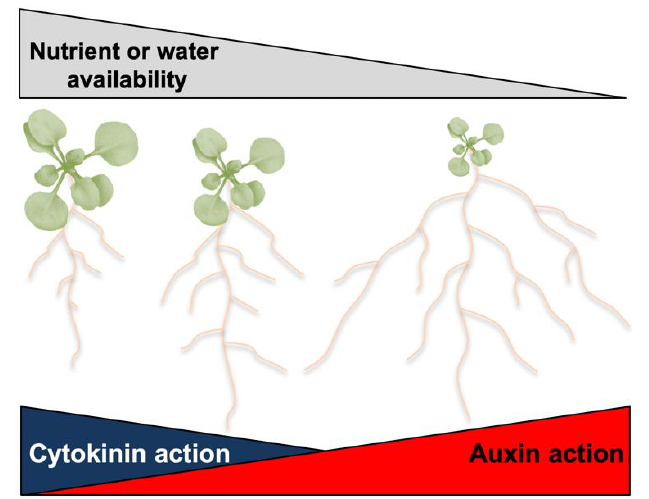
Figure 3. Effects of nutrient or water availability and effects of the auxin/cytokinin ratio on the shoot/root growth ratio.